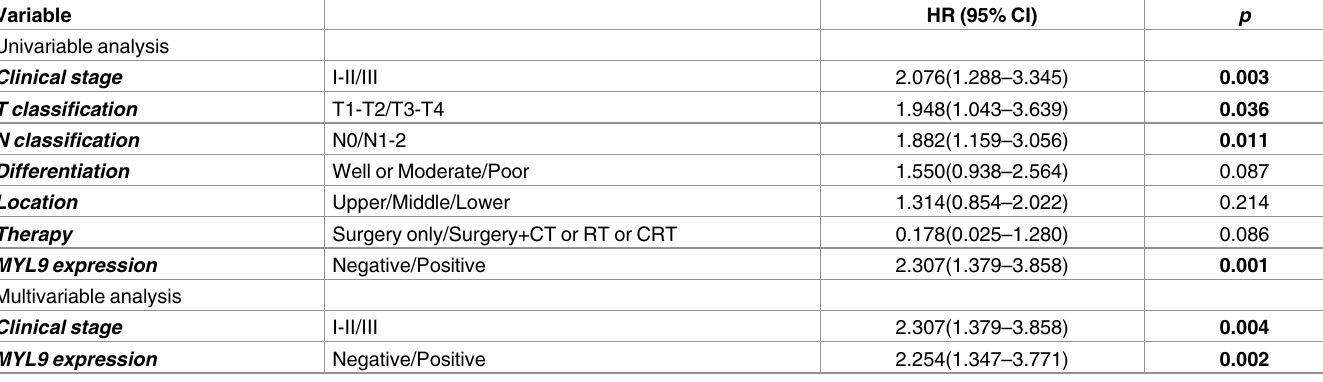
Table 3. Univariable and multivariable analysesof prognostic parameters in patients with ESCC.